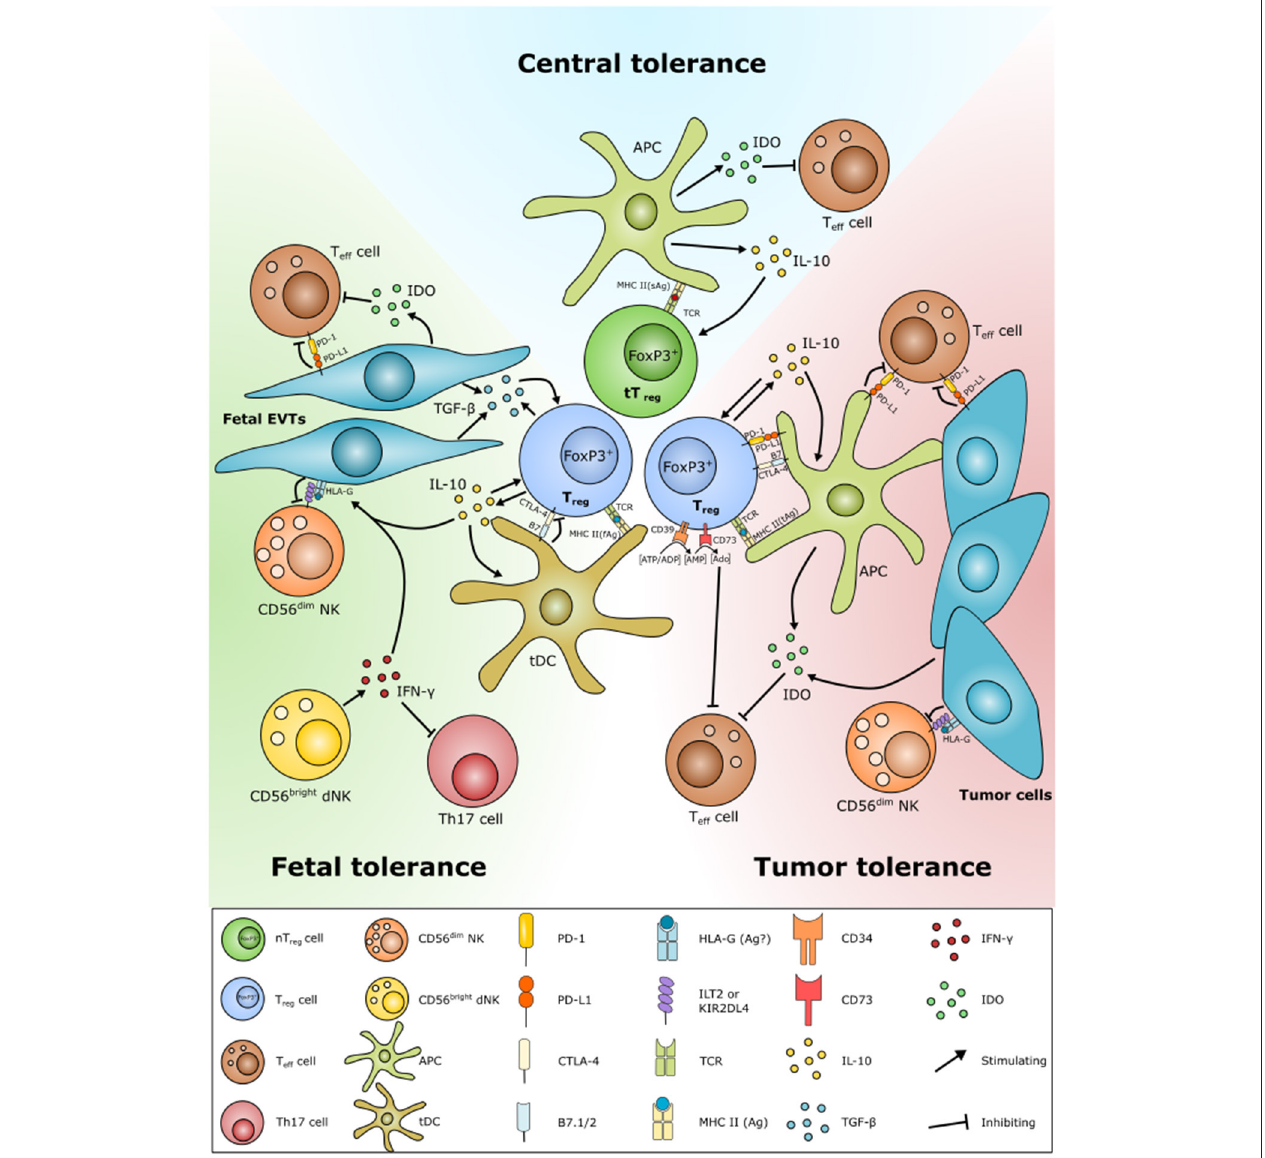
FIGURE 3 | Schematic overview of similarities in Treg function in central tolerance, fetal tolerance, and cancer tolerance. Tolerance play an important role in both fetal and cancer tolerance. Tregs are developed by presentation of antigens of fetal (fAg) or tumor (tAg) origin. Many tumor cells and fetal extravillous trophoblast (EVT) cells have both diminished or no expression of MHC class II and classical MHC class I molecules. Instead, the EVT cells and some cancer cells express HLA class Ib molecules, e.g., the immune modulatory non-classical HLA-G. HLA-G is able to protect fetal and tumor cells from NK cell lysis, as well as according to a few